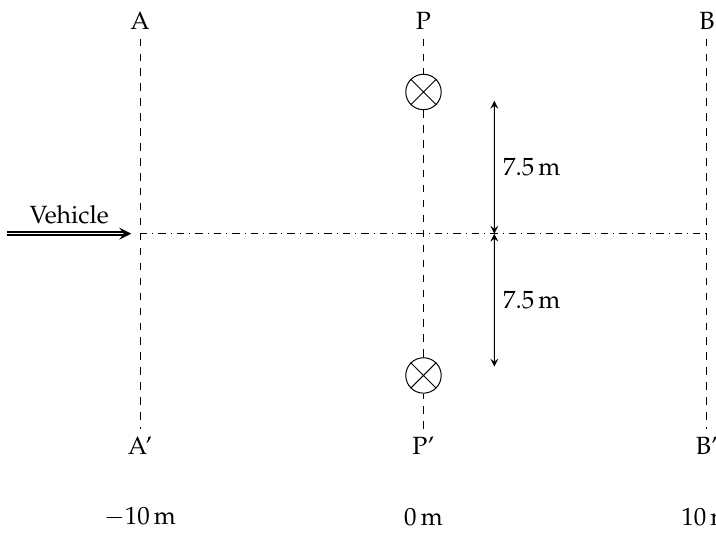
Figure 3. Principal sketch measurement